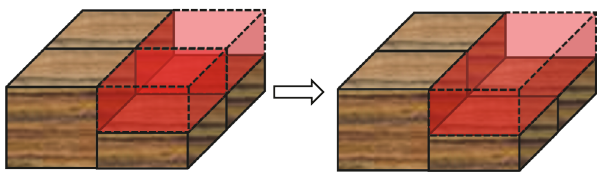
Figure 8: Front-and-back space consolidation.